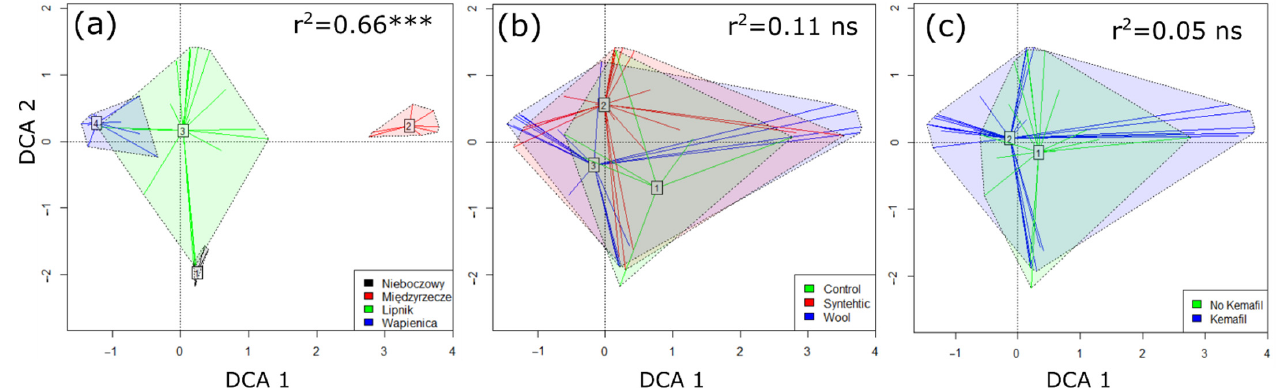
Figure 3. The biplots of Detrended Correspondence Analysis with the passive projection of site ( a ), type of material ( b ) and presence/absence of Kemafil ropes ( c ). *** p < 0.001, ns—non-significant.